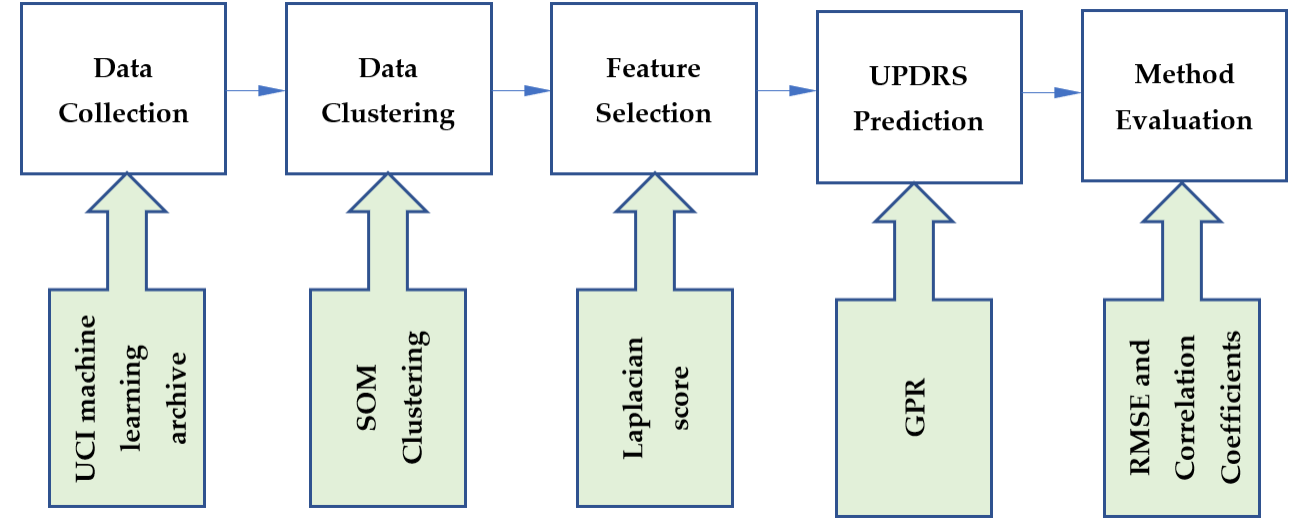
Figure 1. The steps of the proposed